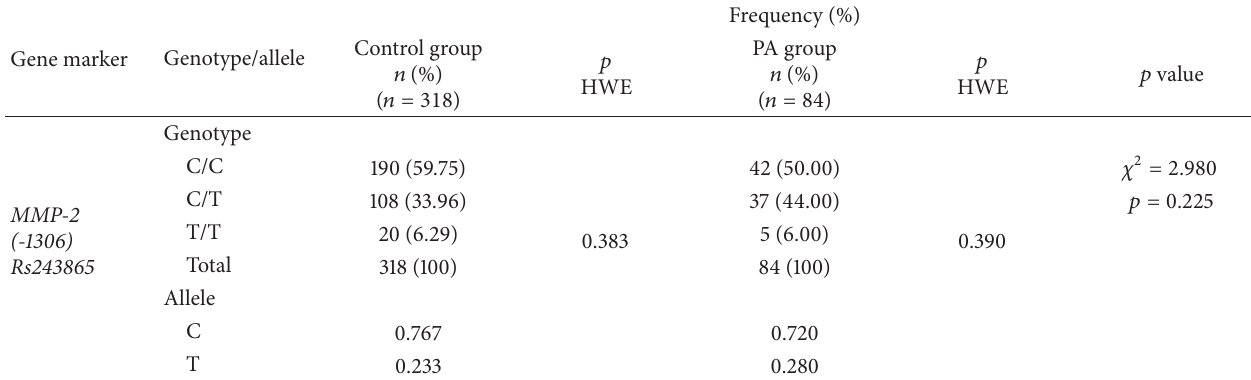
Table 2: Frequency of MMP-2 (-1306 C/T) genotype in the patients with pituitary adenoma (PA) and in the control group.